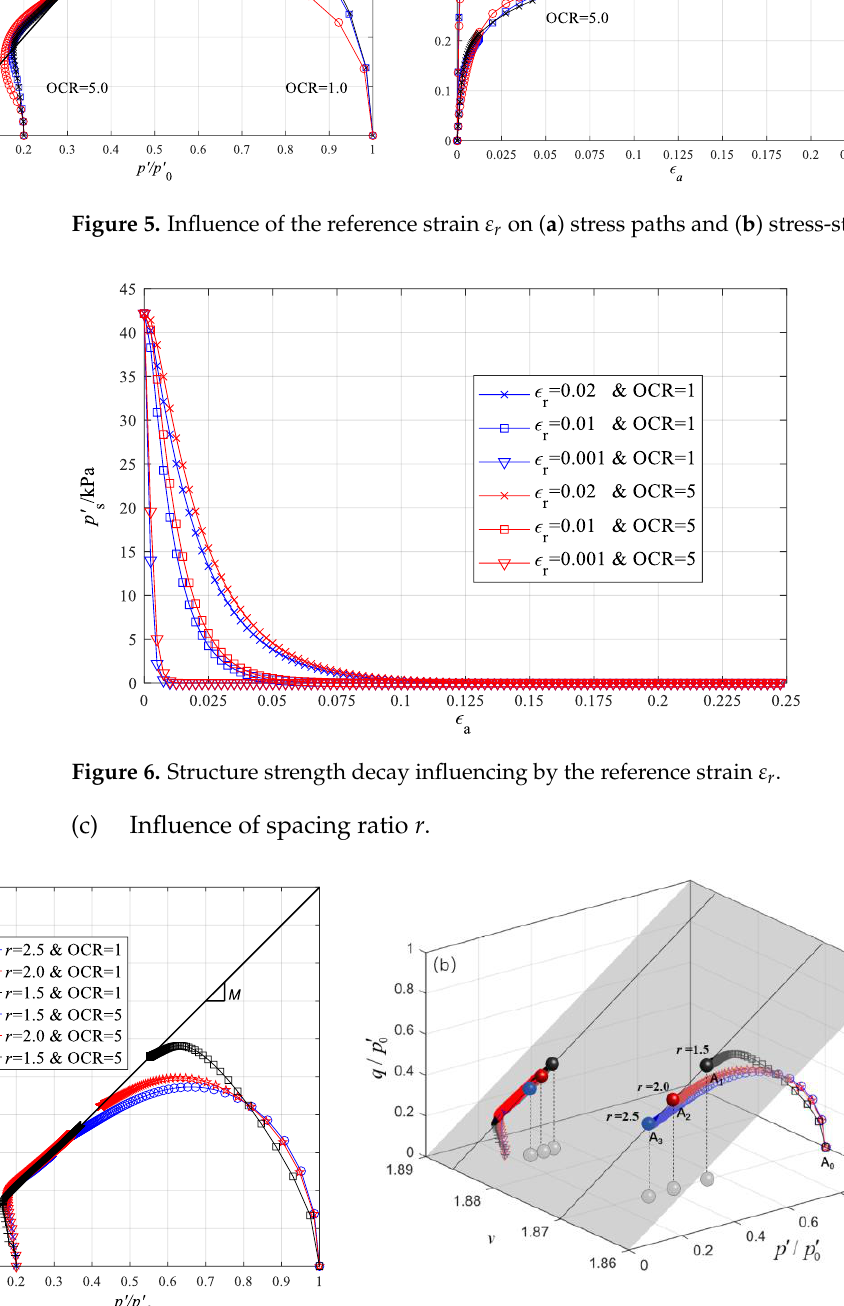
Figure 7. Influence of spacing ratio r on ( a ) stress paths and ( b ) critical states.